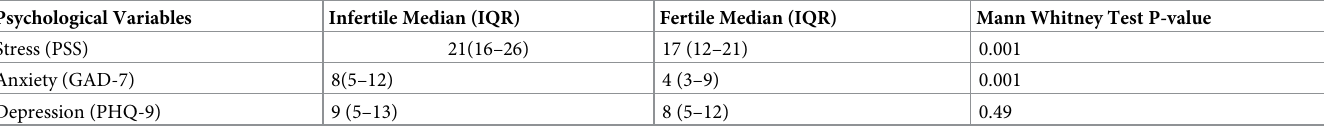
Table 1. Median scores of stress, depression and anxiety among infertile and fertile women.